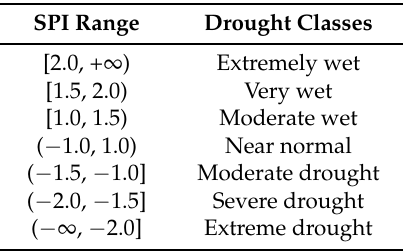
Table 1. Drought levels according to SPI values